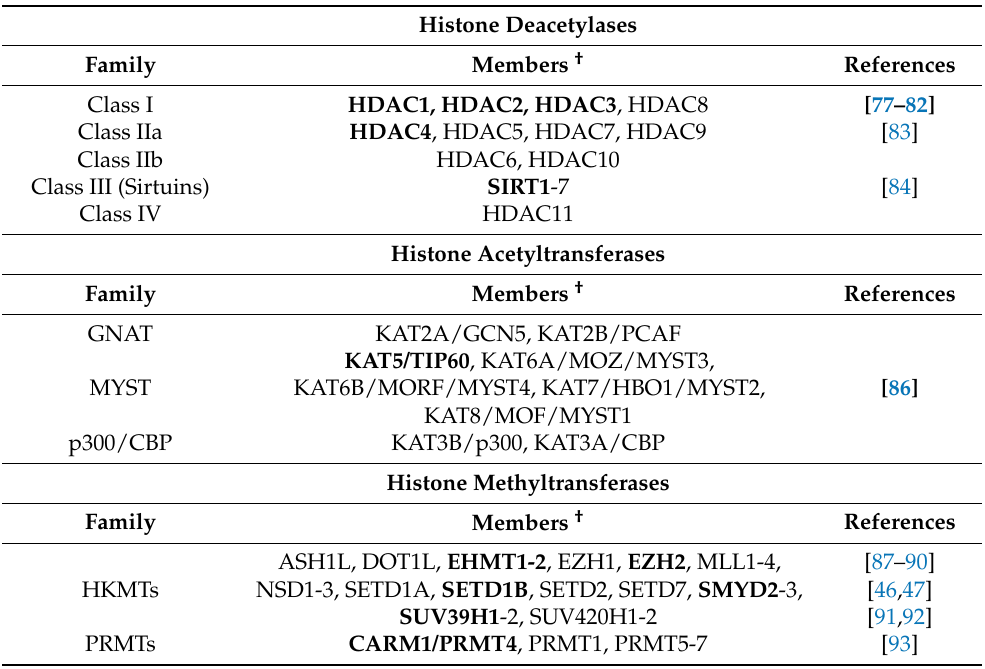
Table 2. Histone modifiers implicated in HIV-1 latent CD4 + T-cell